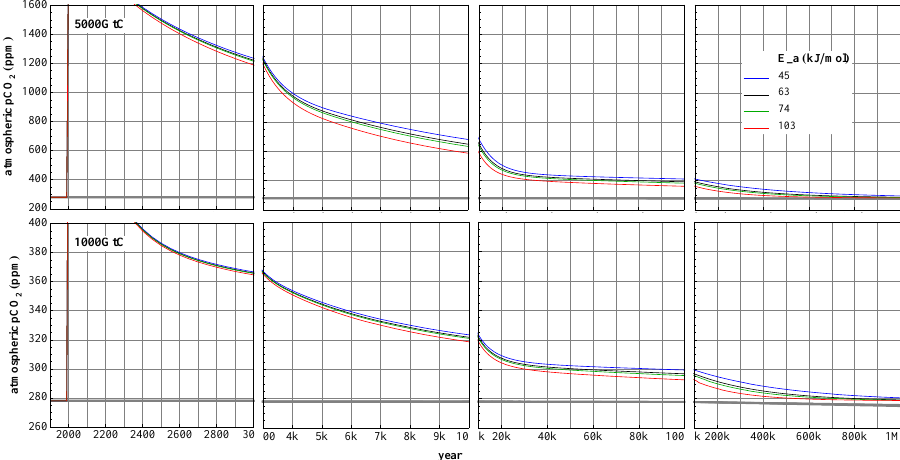
Fig. 7. Evolution of atmospheric CO 2 over 1Myr for 1000GtC (bottom) and 5000GtC (top) emissions pulses, vs. a control run with no emissions (grey lines), with different values of silicate weathering activation energy ( E a ). these ranges to be increasing through to year 500 k, where they become 43 ppm and 69 ppm,